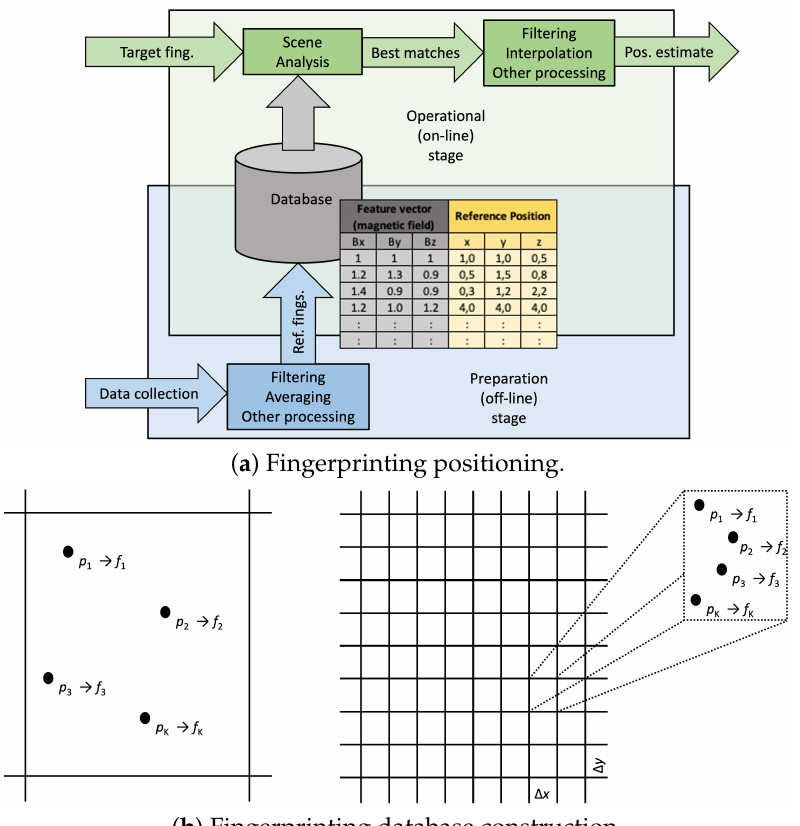
Figure 4. Fingerprinting positioning consists of two stages. During preparation, the database is collected. The feature vector comprises the AC EMR in each axis. In the operational phase, the scene analysis algorithm returns position candidates for the target position. At the bottom, one sees that a fingerprint may contain the positioning features collected at one position (left) or combine the features collected within a